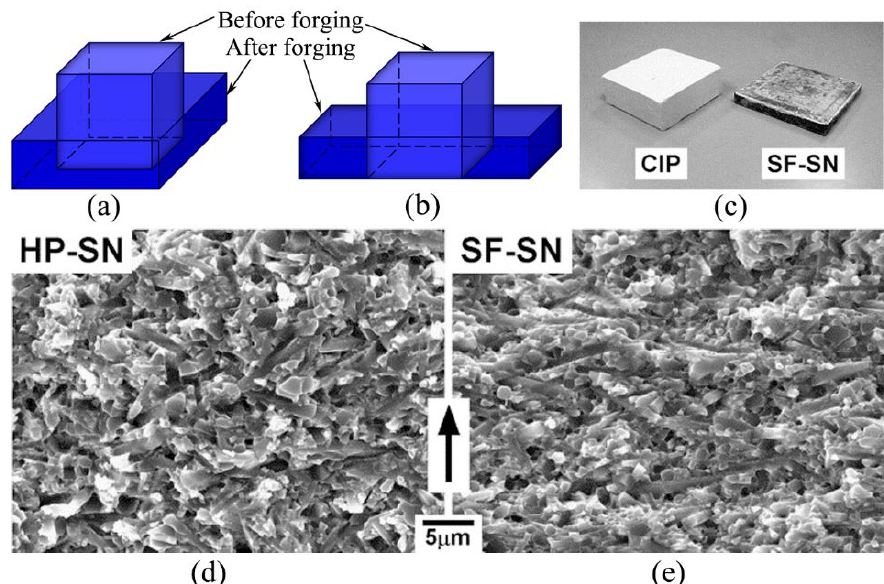
Fig. 9 Preparation and fracture morphologies of textured Si 3 N 4 matrix ceramics prepared by hot working: (a, b) schematic diagram of superplastic deformation under SC and PSC, respectively; (c) CIPed Si 3 N 4 green body (left) and SFed Si 3 N 4 specimen (right); (d, e) fracture morphologies of Si 3 N 4 specimens prepared by HP and SF, respectively. The arrow indicates crack propagation directions. Uniaxial pressure was applied vertically. Reproduced with permission from Ref. [128], © Elsevier Science Ltd. 2002.